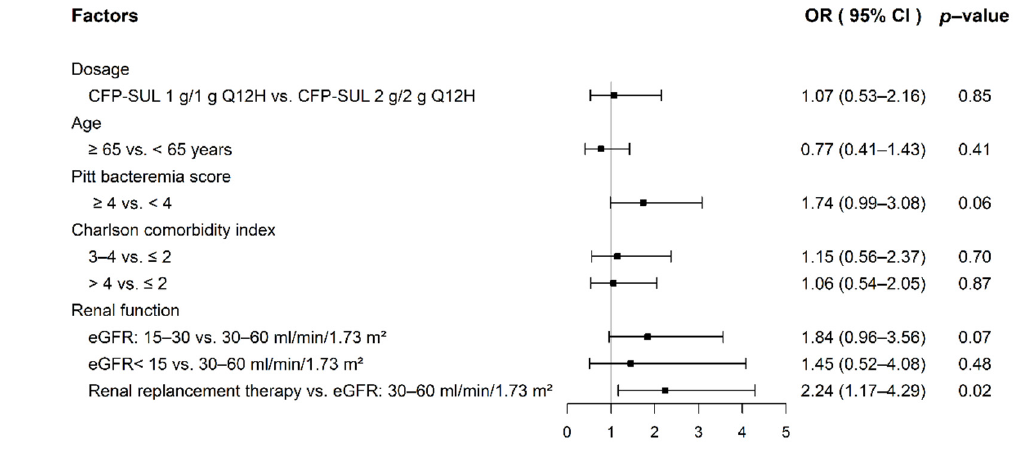
Figure 2. Risk factors for abnormal INR in septicemic patients with impaired renal function.